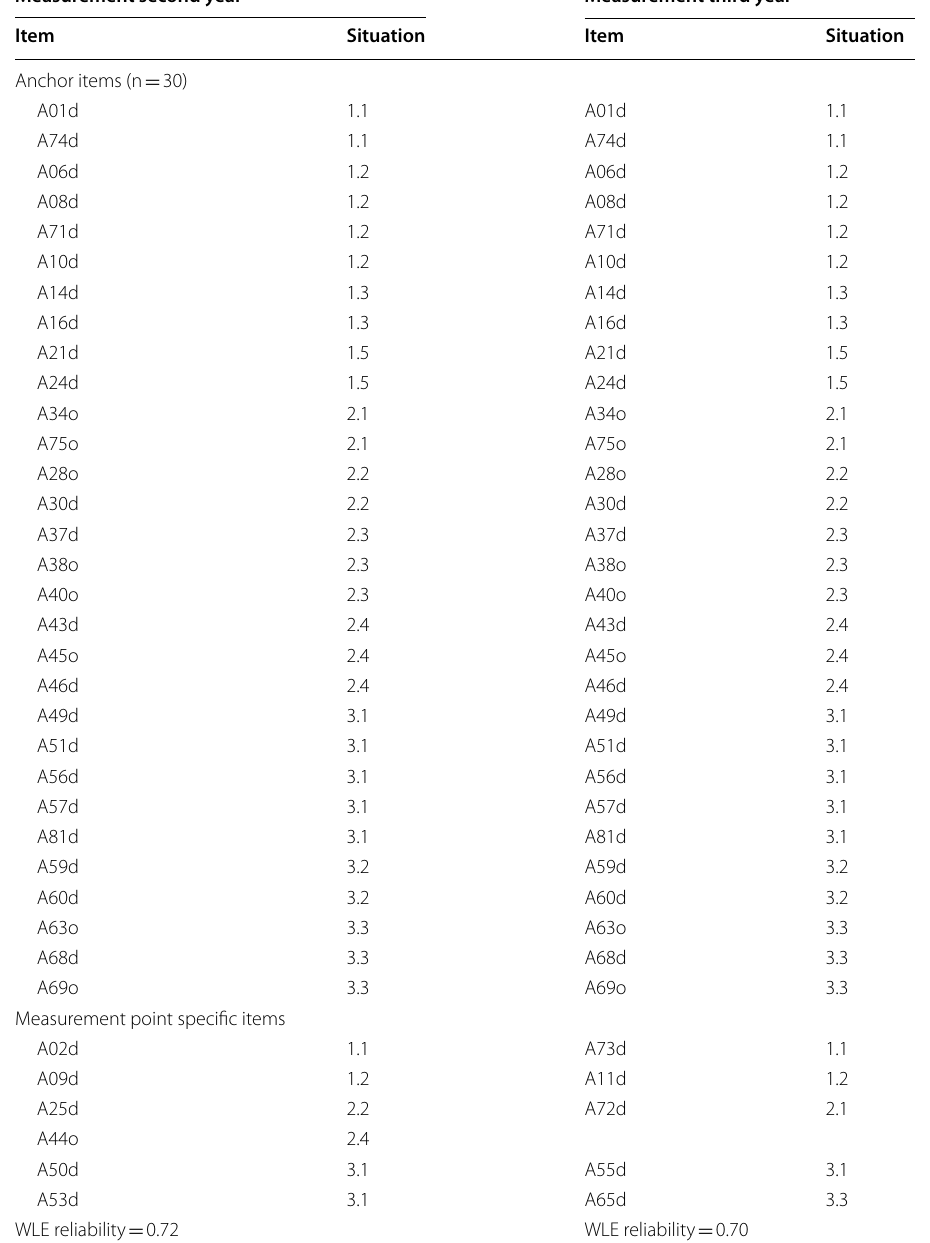
Table 6 Reliability, item selection, and distribution for the first and second point of measurement Measurement second year Measurement third year Item Situation Item Situation Anchor items (n =